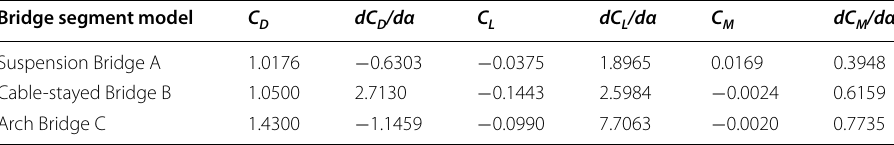
Table 4 The static force coefficients and derivatives of the 0°AOA of the typical large-span bridge segment